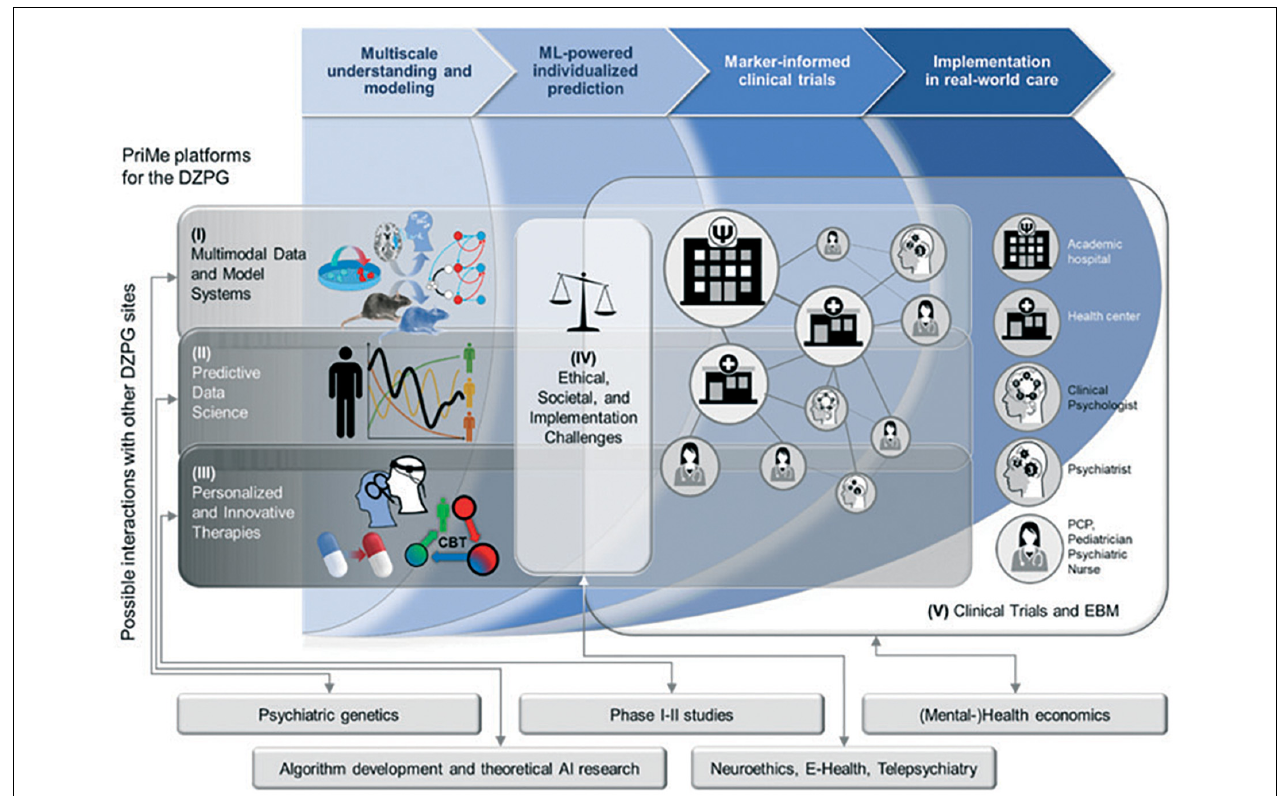
FIGURE 5 | Mapping between PRiME’s translational chain and envisaged research platform in the new German Centre for Mental Health (DZPG). These platforms will be generic and thus accessible by all sites of the DZPG to facilitate the rapid translation of knowledge into therapies for all mental disorders. Boxes represent topics where PriMe could benefit from the expertise of other potential DZPG sites. AI, artificial intelligence; DZPG, German Center for Mental Health; EBM, evidence-based medicine; and ML, machine